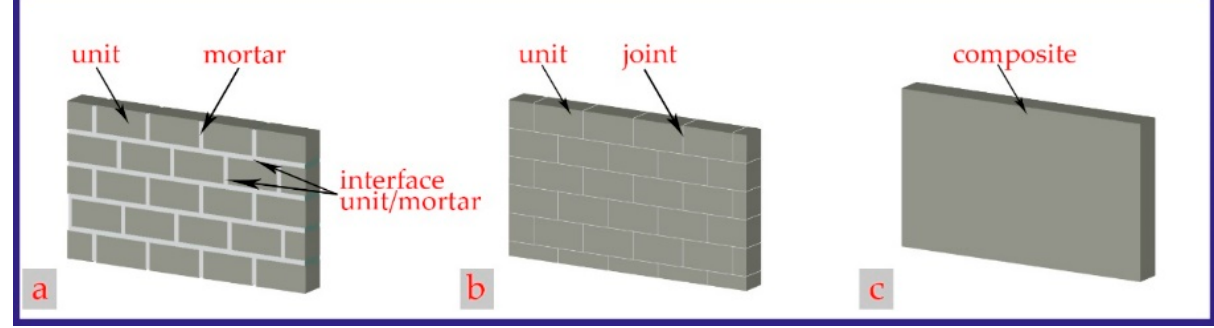
Figure 18. Modeling methods of masonry: ( a ) detailed micro modeling; ( b ) simplified micro modeling; ( c ) macro modeling.